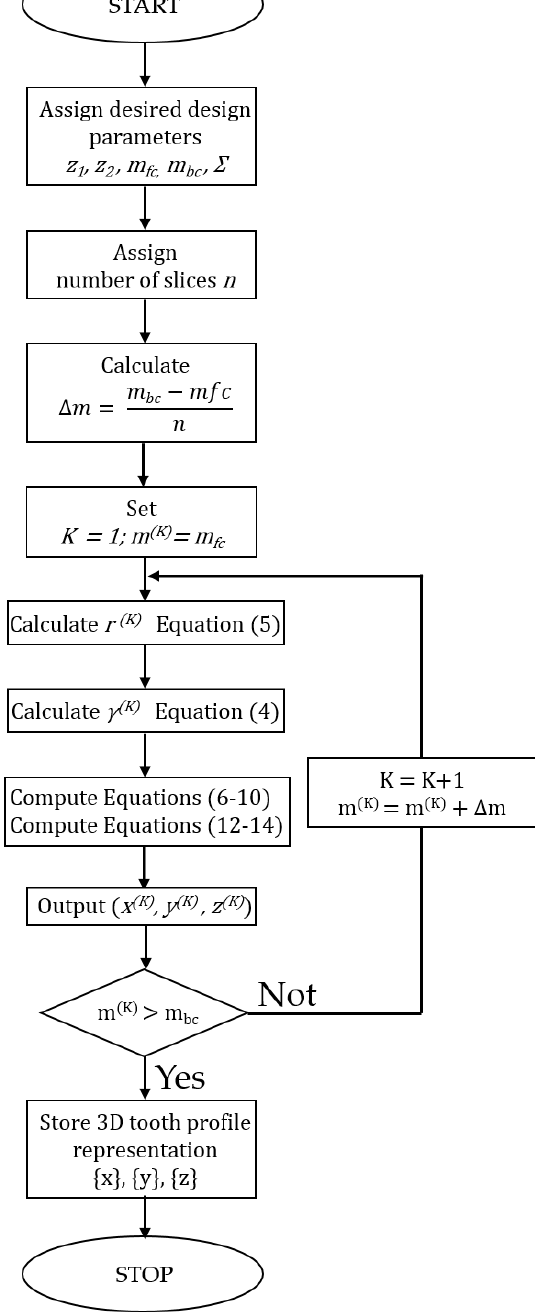
Figure 3. Overview of major steps of the tooth flank generation process.